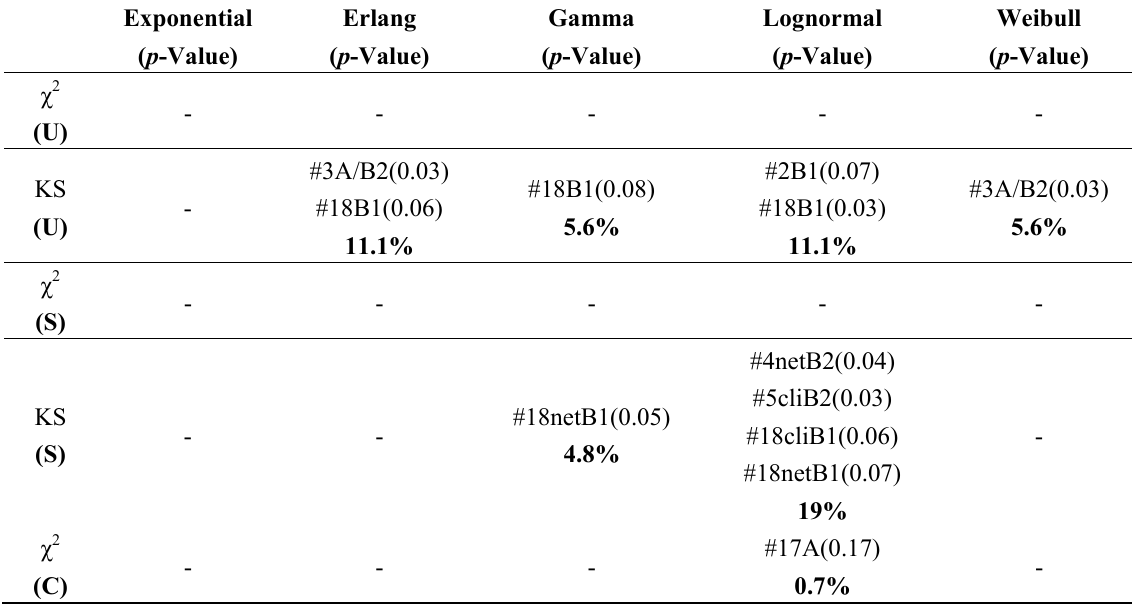
Table 7. Comparative table of non-rejected scenarios for unprocessed (U), split (S) and confidence interval method (C) with parametrical distributions (unprocessed and split values are copied from tables 4 and 5